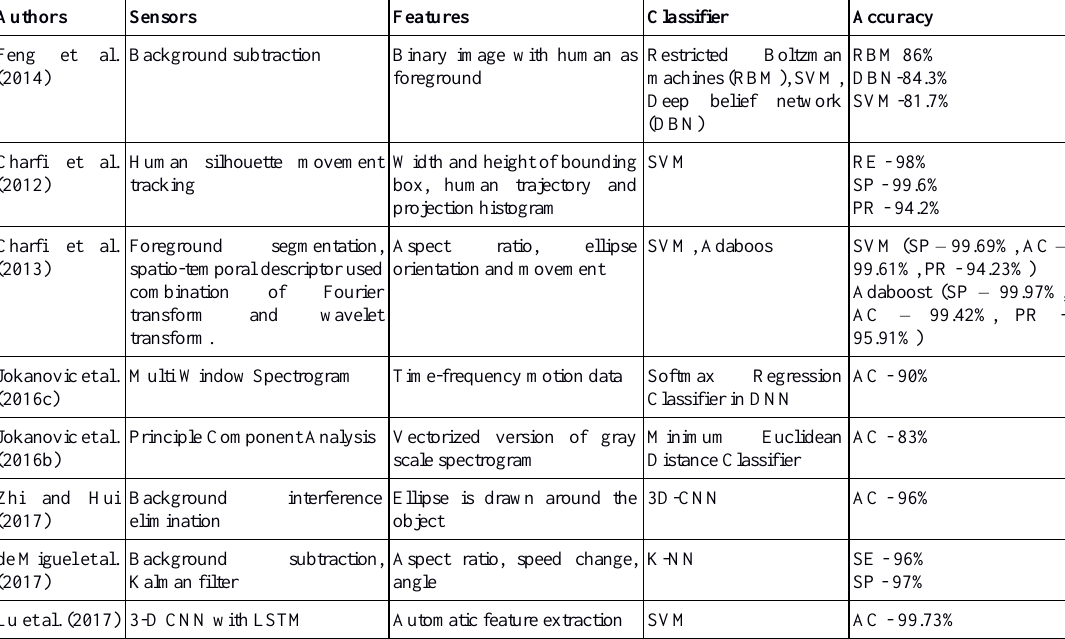
Table 5. Vision-based fall detection systems